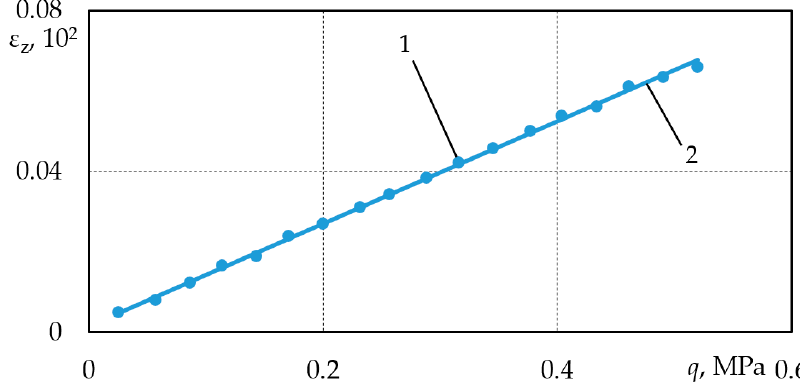
Figure 6. Summary experimental data: 1—experimental data; 2—generalized line.